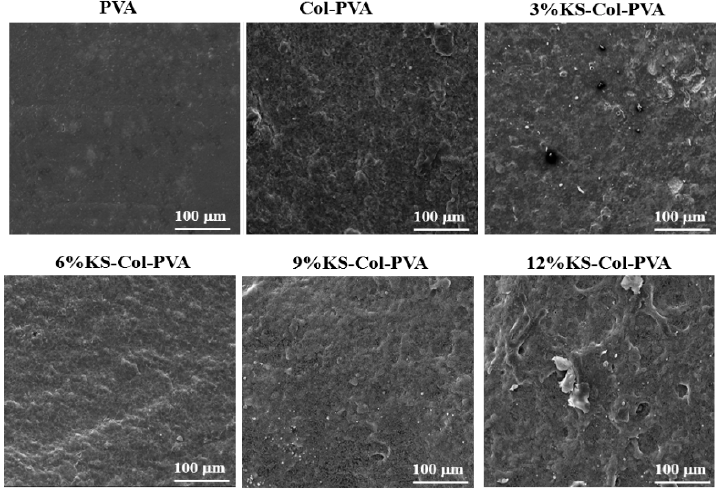
Figure 1. SEM micrographs of the PVA, Col-PVA, and KS-Col-PVA films.